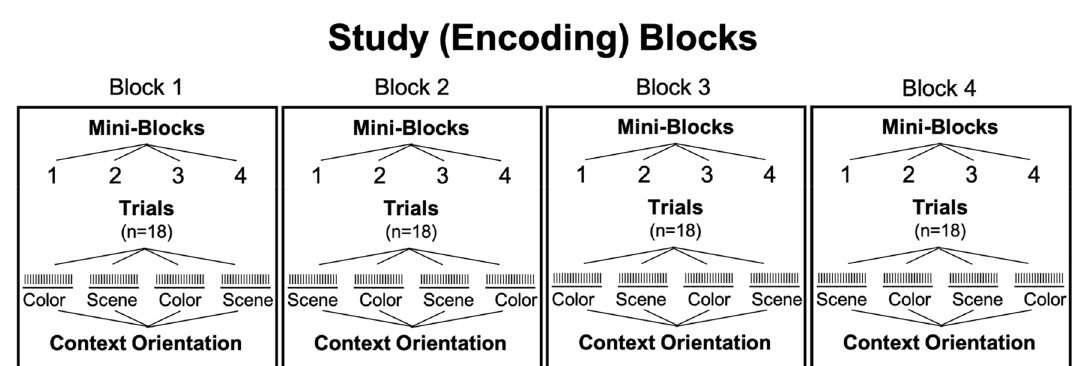
Figure 2. Mini-block design of study phase. Four mini-blocks per study block, 18 trials per